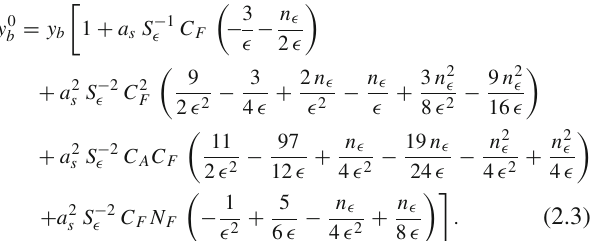
NLO The NLO virtual corrections are directly related the one-loop form factor for which we get in fdh / dred